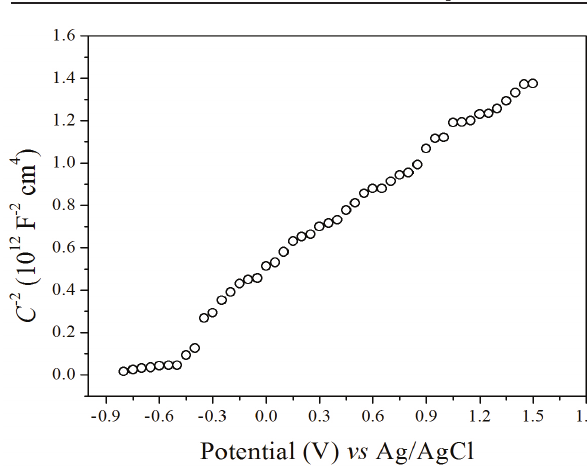
in 0.1 M KCl at 100 Hz 2